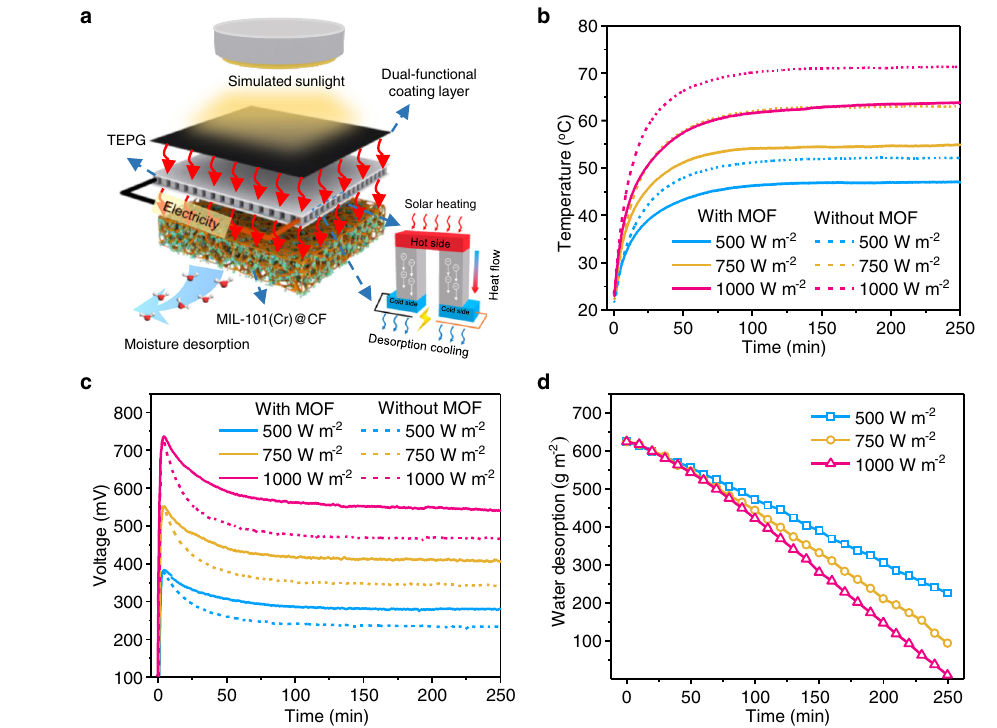
Fig. 4 |Demonstrationofsynergistic effectofthehybridSAWH-TEPGdevicein the daytime. a Schematic diagram of the moisture desorption and power gen- eration under the solar simulator. b Temperature evaluations of TEPG bottom in the hybrid SAWH-TEPG device with MIL-101(Cr)@CF and the referenced device withoutMIL-101(Cr). c VoltageevaluationsoftheTEPGmoduleinthehybriddevice